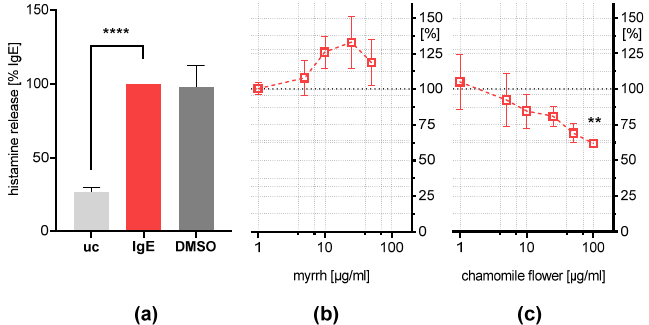
Figure 4. Effects of the plant extracts on the histamine release of IgE-stimulated RBL-2H3 cells. Histamine release was determined after overnight (18 h) incubation with IgE (500 ng/mL) following 30 min stimulation with 1 µg/mL DNP-HSA (IgE = 100%) compared to the untreated control (UC) and vehicle control (IgE + 0.2% DMSO) ( a ). ( b ) Myrrh resin extract (1–50 µg/mL), ( c ) chamomile flower extract (1–100 µg/mL), or ( d ) coffee charcoal extract (1–100 µg/mL) were incubated simultaneously to IgE. Results are presented as means ± SEM; n = 5; ** p < 0.01; **** p < 0.0001.